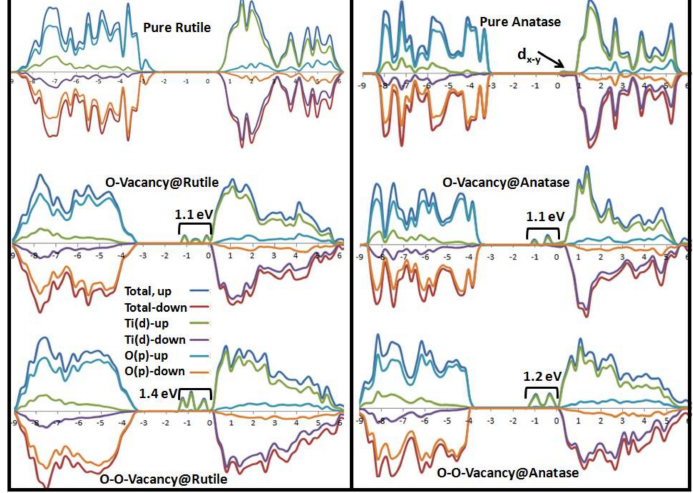
Figure 1. Total and partial density of states of the pure, O-vacancy@-, and O-O-vacancy@rutile and anatase bulk.